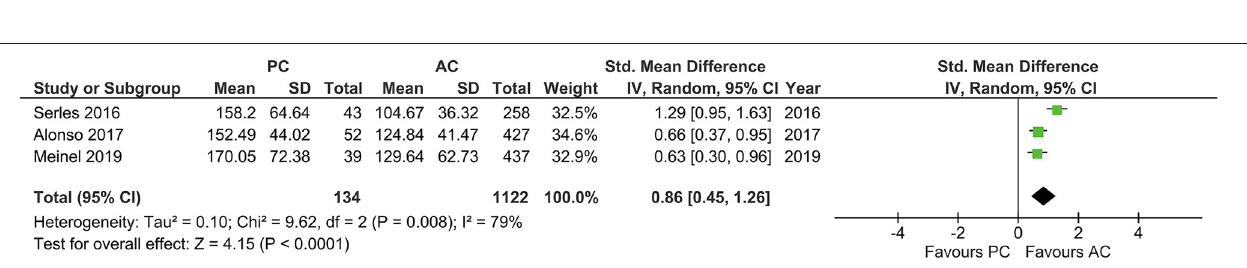
FIGURE 6 | Forest plot comparing “onset-to-intravenous thrombolysis time” in patients with large vessel occlusion in the posterior circulation (PC) vs. anterior circulation (AC) who were treated with endovascular mechanical thrombectomy. Chi 2 , chi-square statistic; CI, confidence interval; df, degrees of freedom; I 2 , I -square heterogeneity statistic; IV, weighted mean difference; P , p -value; SD, standard deviation; Std., standardized; Tau 2 , estimated variance of underlying effects across studies; Z , Z statistic.